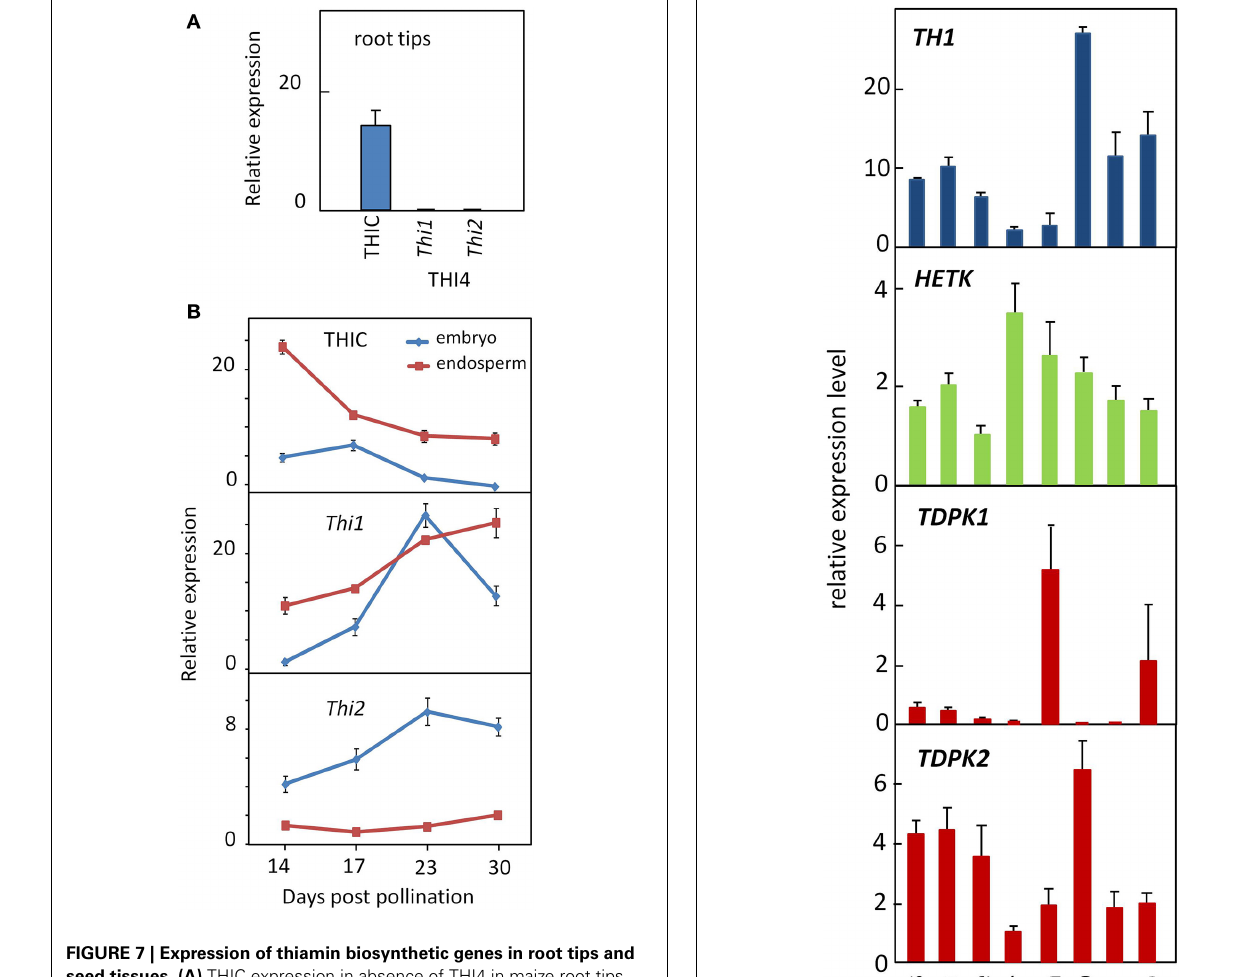
FIGURE 7 | Expression of thiamin biosynthetic genes in root tips and seed tissues. (A) THIC expression in absence of THI4 in maize root tips. (B) Divergent regulation of THIC and THI4 genes in developing embryo and endosperm. Expression of THIC, Thi1 and Thi2 genes in root tips and developing embryo and endosperm was assayed by qRT-PCR (Guan et al., 2012; see Methods). Trace amounts of Thi1 and Thi2 transcripts were detected in root tips. Error bars are standard error of the mean ( n = 3).